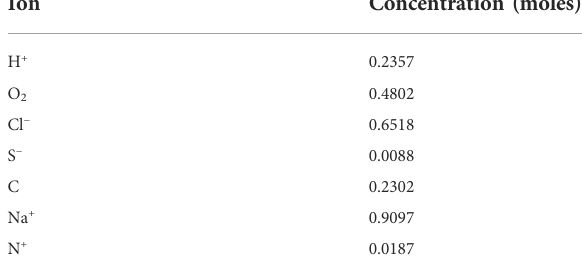
TABLE 3 Composition of the fl uid used in the